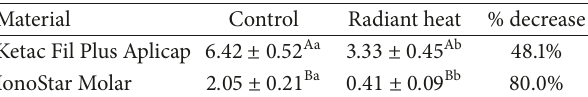
Table 4: Mean values and standard deviations of surface loss ( 𝜇 m) of the experimental groups of the study after abrasive procedures. The same uppercase superscripts in columns indicate no significant differences between materials (𝑝 > 0.05) . The same lowercase superscripts indicate no significant differences between treatments (𝑝 > 0.05) . Material